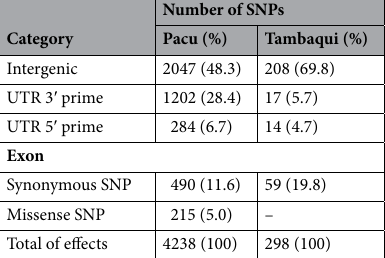
Table 5. Classification of SNPs from RNA-Seq included in the array, considering the annotation of 4093 SNPs from pacu and 294 SNPs from tambaqui. Percentage values are between